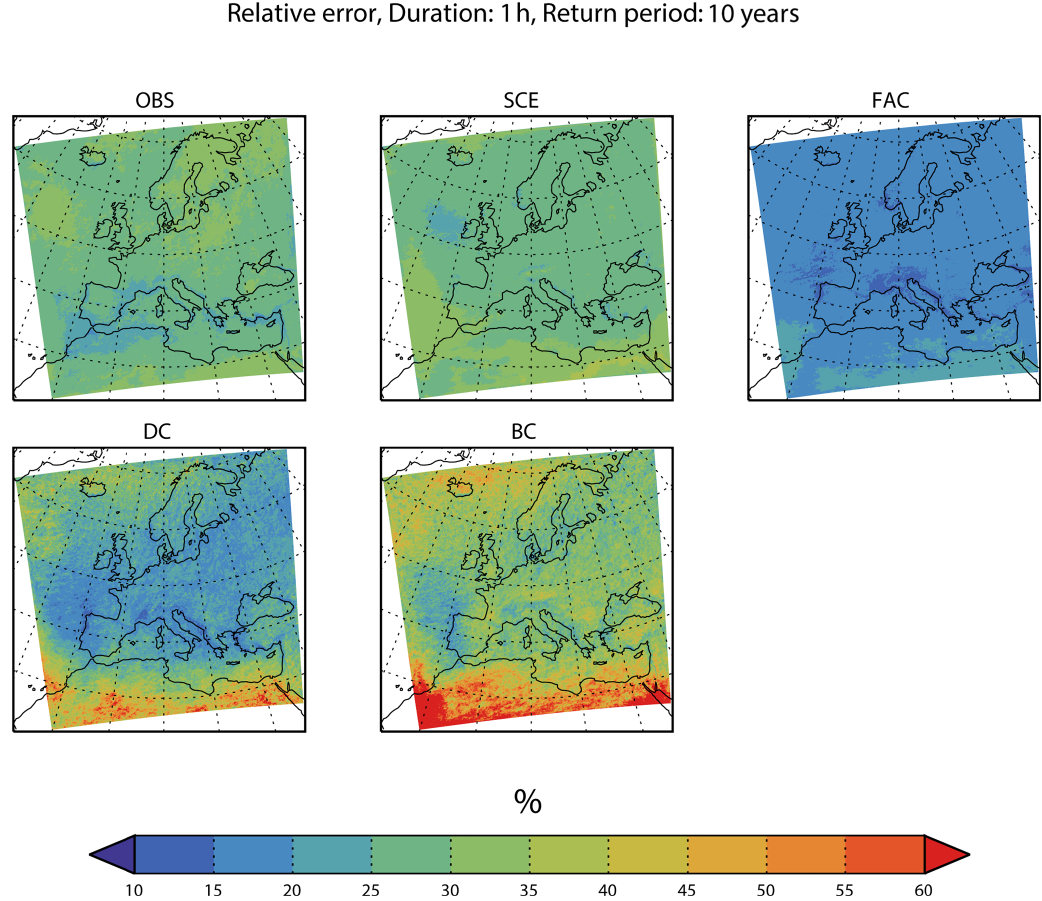
Figure 5. Geographical distribution of the relative error of the end-21st-century 10-year return level for a 1h duration precipitation in- tensity from the inter-model cross-validation. Colours show the median of the relative error calculated over all model/pseudo-observation combinations. Panels show the different adjustment